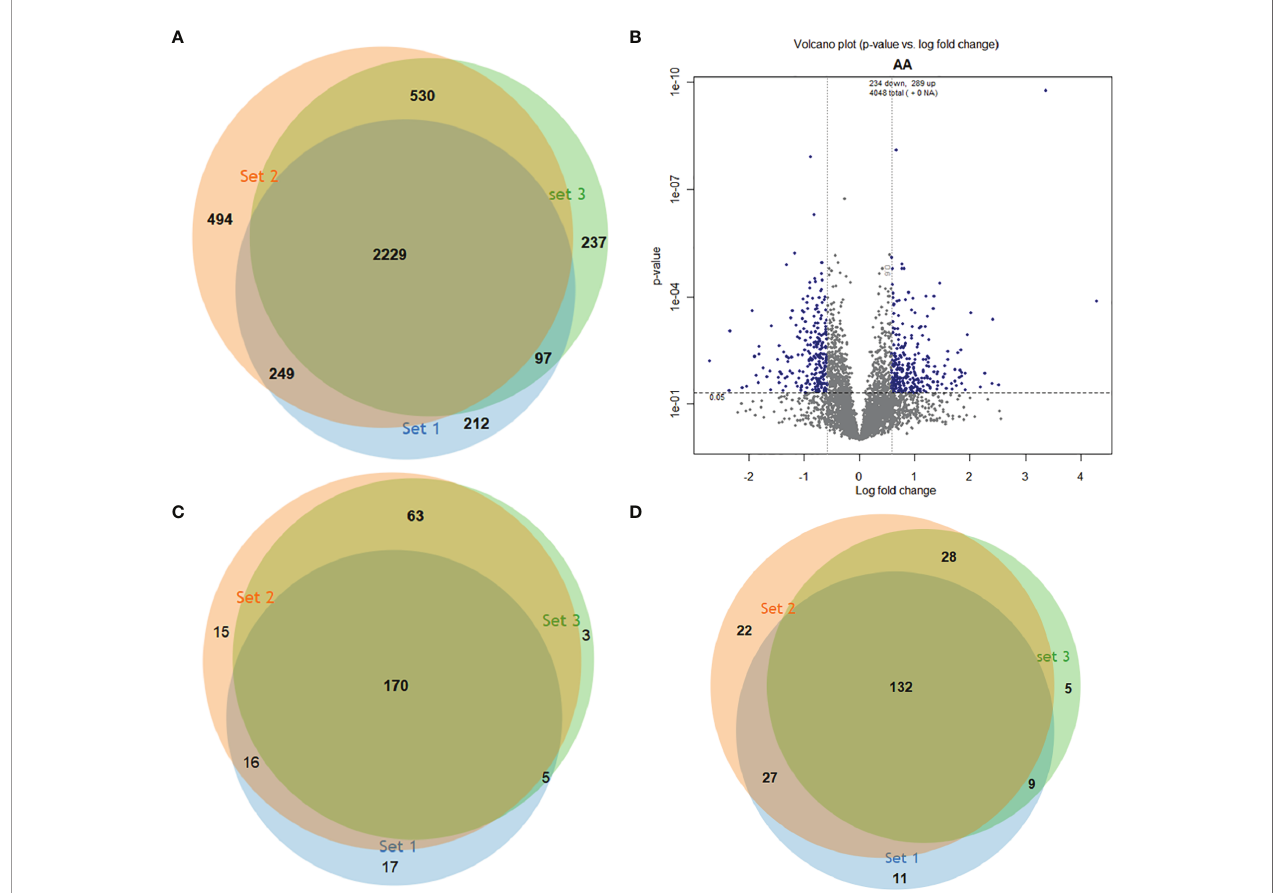
FIGURE 1 | Identi fi cation of differentially abundant proteins in three experimental replicates. (A) Venn diagram showing the 4,048 proteins identi fi ed in the 3 independent runs. (B) Volcano plot of proteins with statistically signi fi cant changes in abundance after ANOVA ( P <0.05) (y axis) and fold change in log2 of 0.584 (1.5) (x axis). (C) Upregulated proteins in each run. (D) Downregulated proteins in each